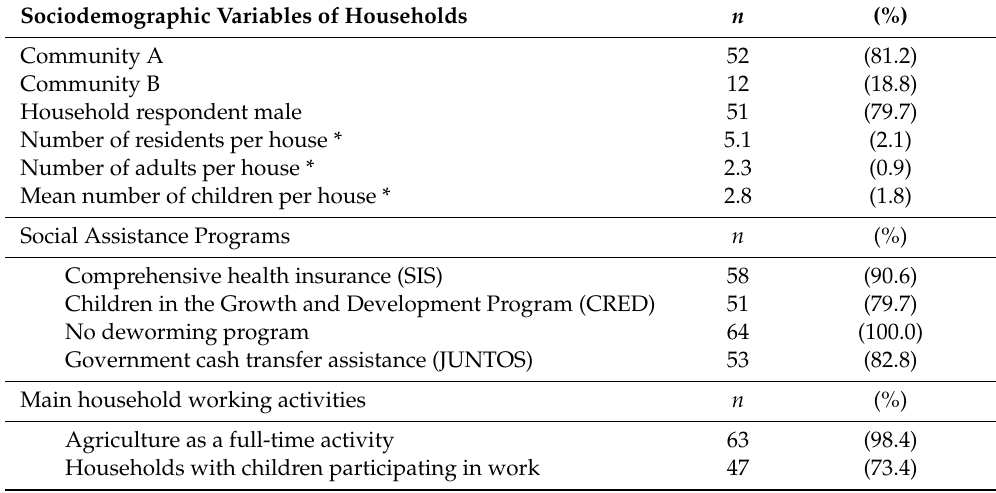
Table 1. The description of sociodemographic variables in the two Shawi communities, Peru ( n = 64). Sociodemographic Variables of